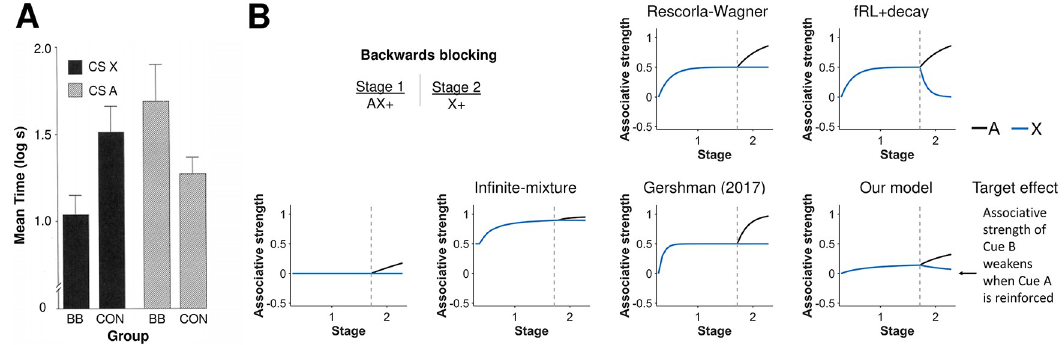
Fig 6. Associability depends on history of cue presentation. A) Experimental results of a backwards blocking experiment from Miller and Matute [43]. After two stages of the experiment, a backwards blocking group (BB) had significantly slower response time to Cue X than a control group (CON) even though Cue X was presented in an identical manner between groups. Their result suggested the associative strength of Cue X can change on trials it is not presented. Reprinted from “Biological Significance in Forward and Backward Blocking Discrepancy Between Animal Conditioning and Human Causal Judgement” by R.R. Miller and H. Matute, 1996, Journal of Experimental Psychology , 125 , p. 374. Reprinted with permission from the American Psychological Association. B) Simulation of a backwards blocking experiment. In our model, associability depends on the history of cue presentation through effort matrices. After the combined associative strength of Cue A and Cue X is learned, these effort matrices rotate the direction of learning into the direction of the difference of Cue A and Cue X. As a result, associative strength of Cue X decreases even though Cue A is presented alone, thereby allowing our model to capture backwards blocking. Gray dashed lines demarcate experimental